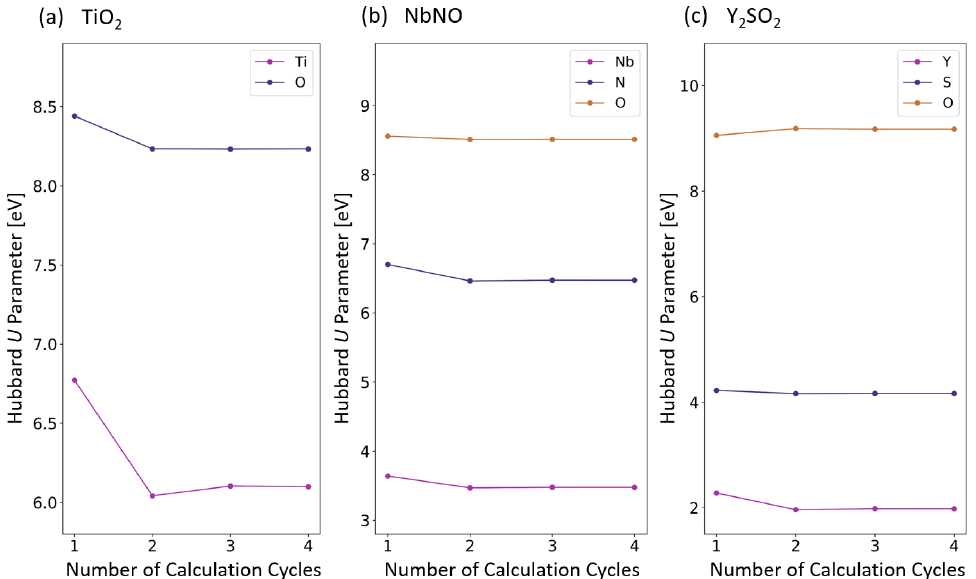
Figure A2. Convergence of the Hubbard U parameter with respect to the number of self-consistent cycles for 3 representative materials from our dataset: ( a ) TiO 2 , ( b ) NbNO, and ( c ) Y 2 SO 2